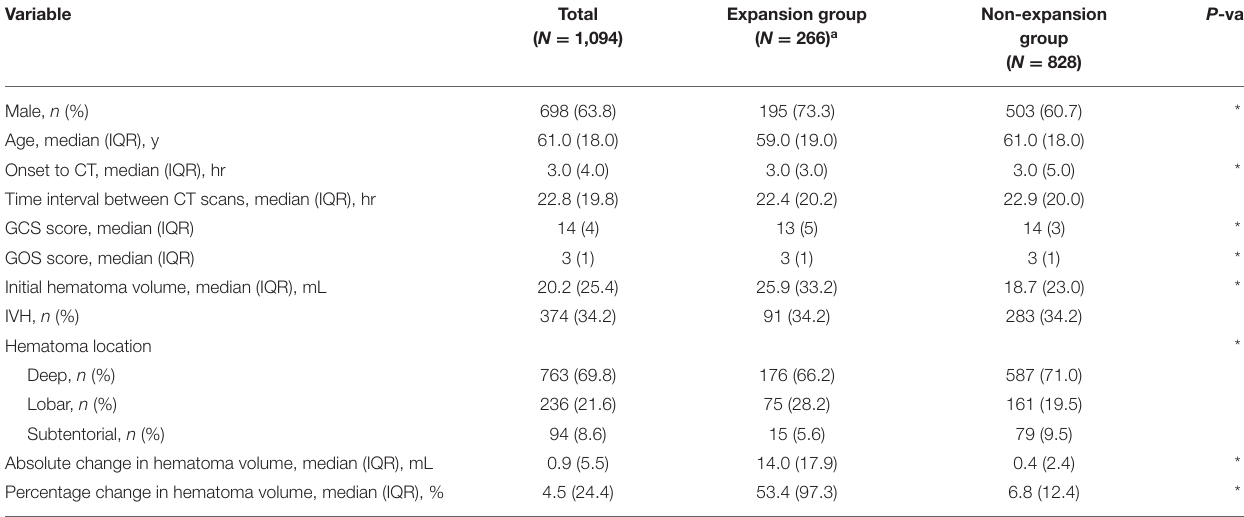
TABLE 1 | Baseline characteristics of ICH